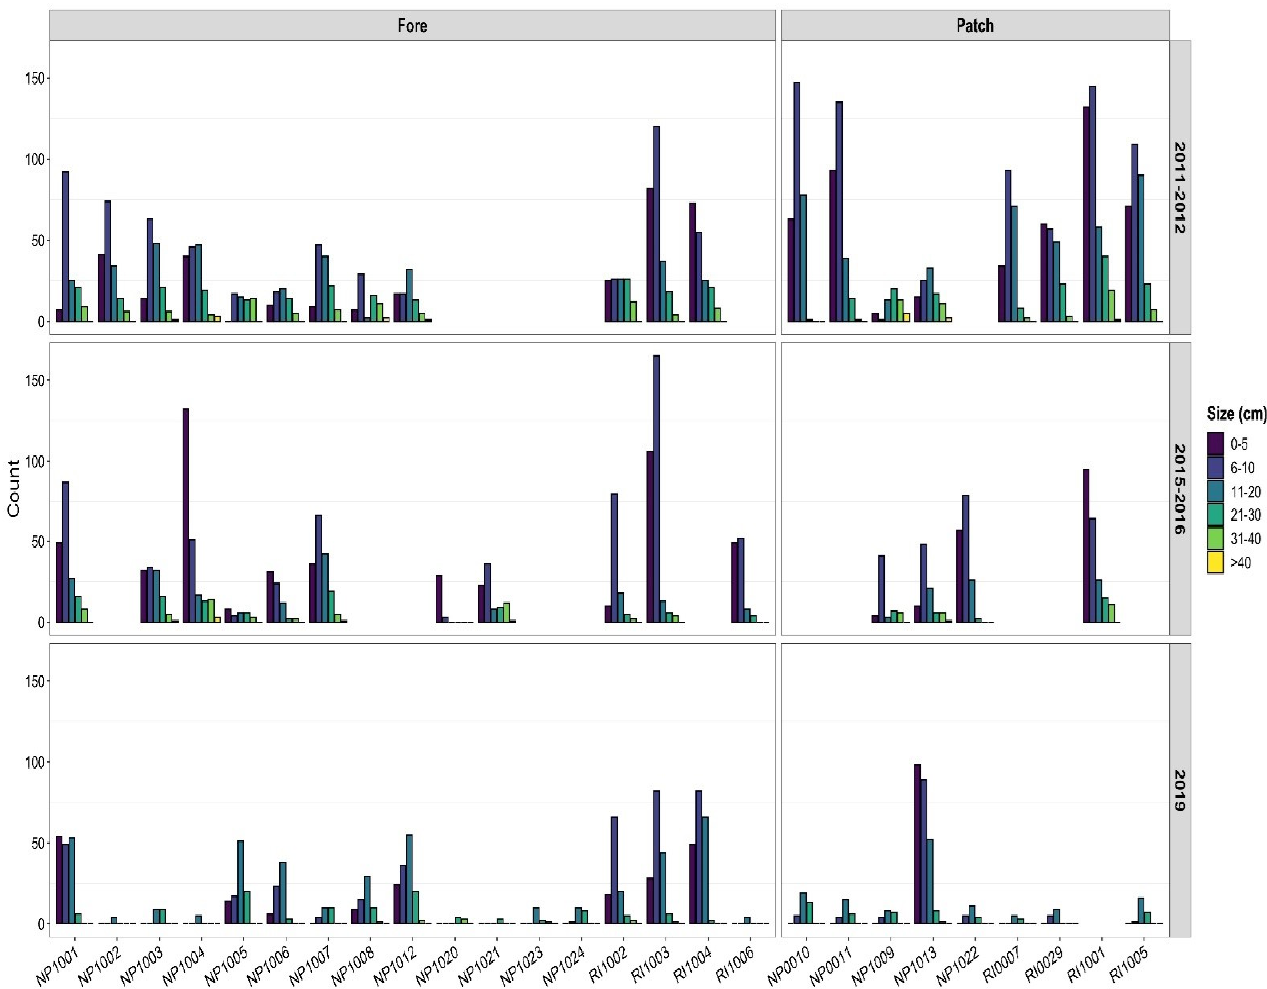
Figure 6. Size frequency distribution showing the total number of all parrotfish in different size classes across each survey period for New Providence. Sites with dashed lines indicate zeros and those with completely blank spaces represent sites where no data were collected during that survey period.